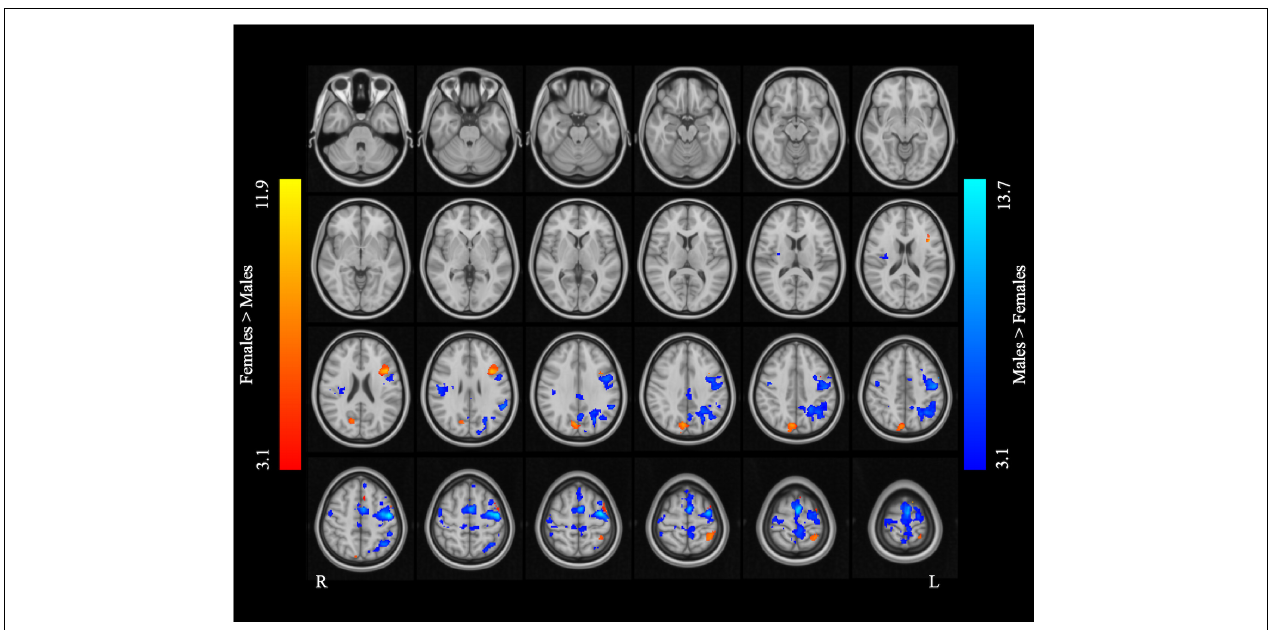
FIGURE 2 | Main effect of sex across the two language tasks. The areas rendered by the red-yellow color scale indicate greater activation in females compared to males, whereas the areas rendered by the blue-light blue color scale indicate greater activation in males relative to females (Z-score > 3.1, cluster size > 200 voxels, corrected p < 0.05).